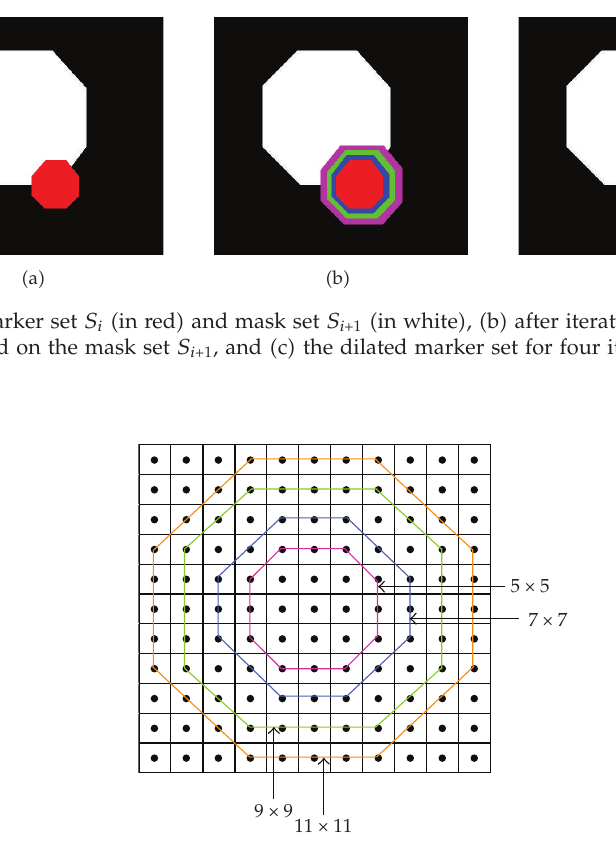
Figure 5: Octagonal symmetric structuring elements of various primitive-sizes ranging from 5 × 5 to 11 × 11. These primitive sizes can be considered as B in the employed equations to simulate flow fields with various